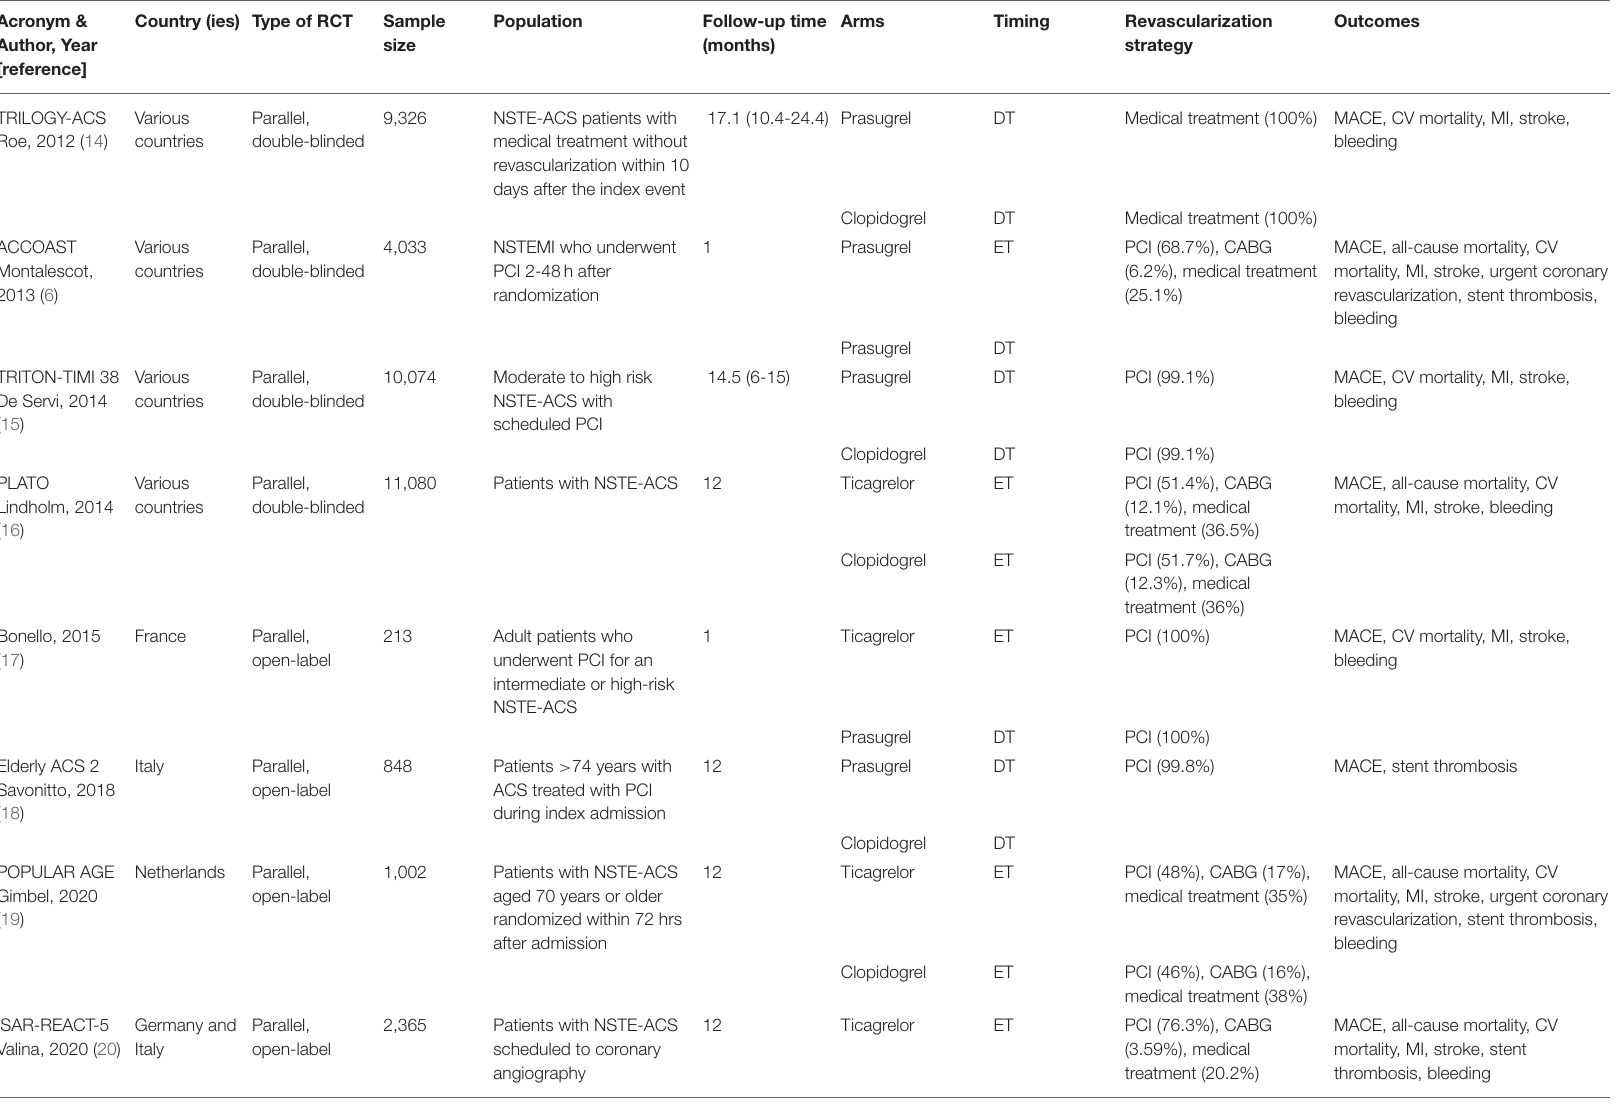
TABLE 1 | Characteristics of included randomized controlled